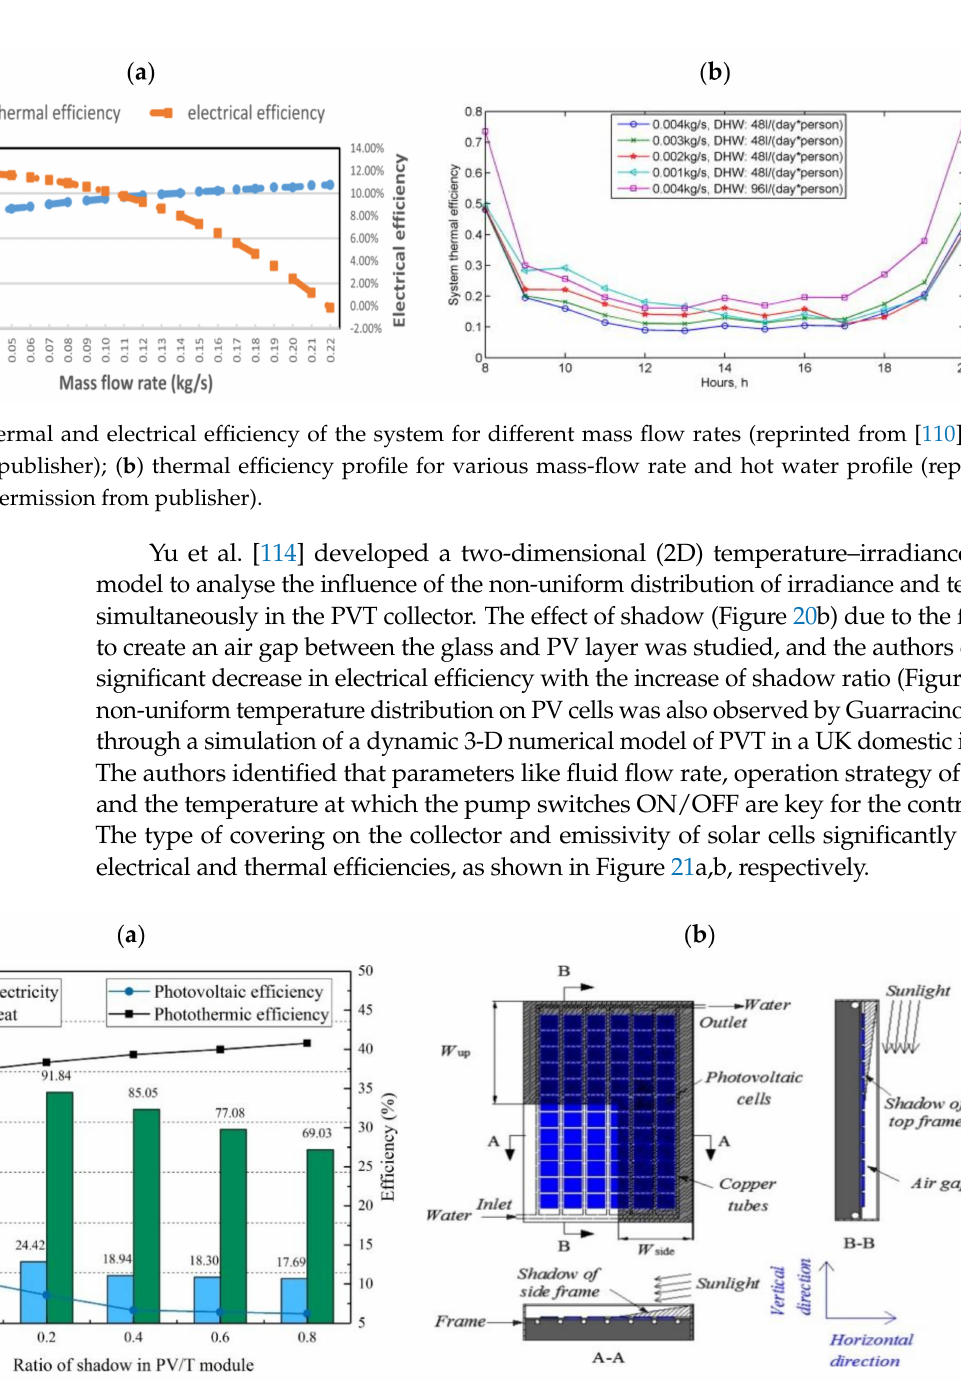
Figure 20. ( a ) Change in electrical and thermal efficiency as a function of shadow ratio; ( b ) frame shadow on PV/T collector surface (reprinted from [114], with permission from